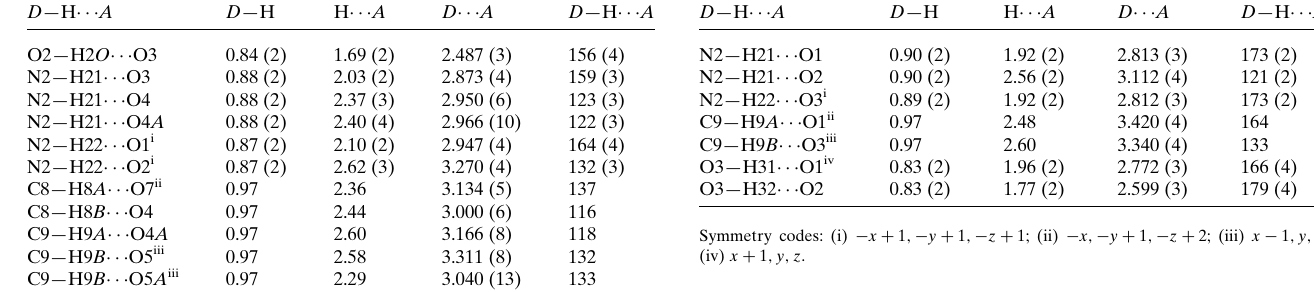
Table 9 Hydrogen-bond geometry (A˚ , (cid:5) ) for 10